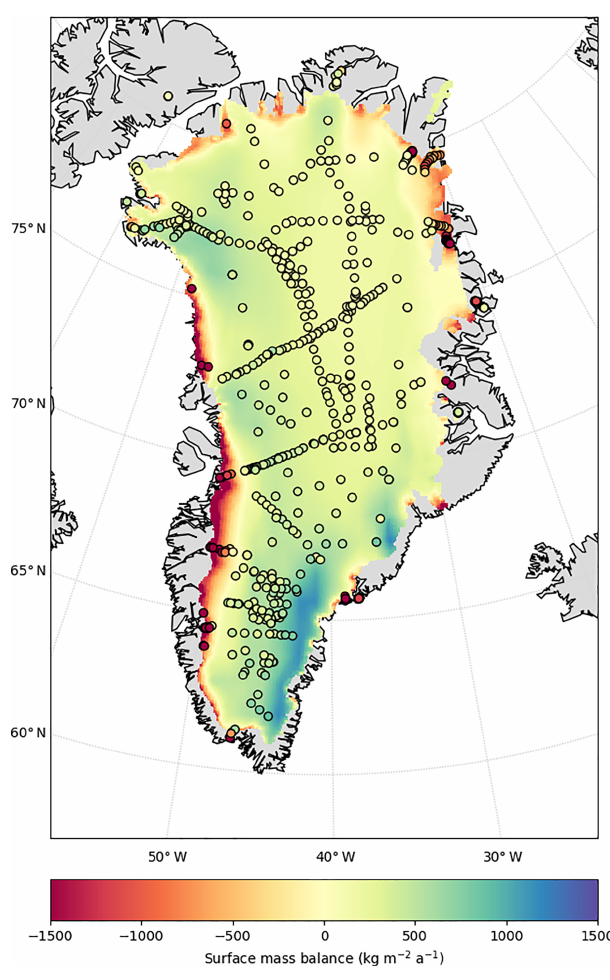
Figure 11. Filled contours of the annual SMB of the Greenland land ice as modeled by CESM, with pit/core field estimates overlaid as filled circles. Data were compiled as detailed in Sect. 2 from both ablation and accumulation zones.